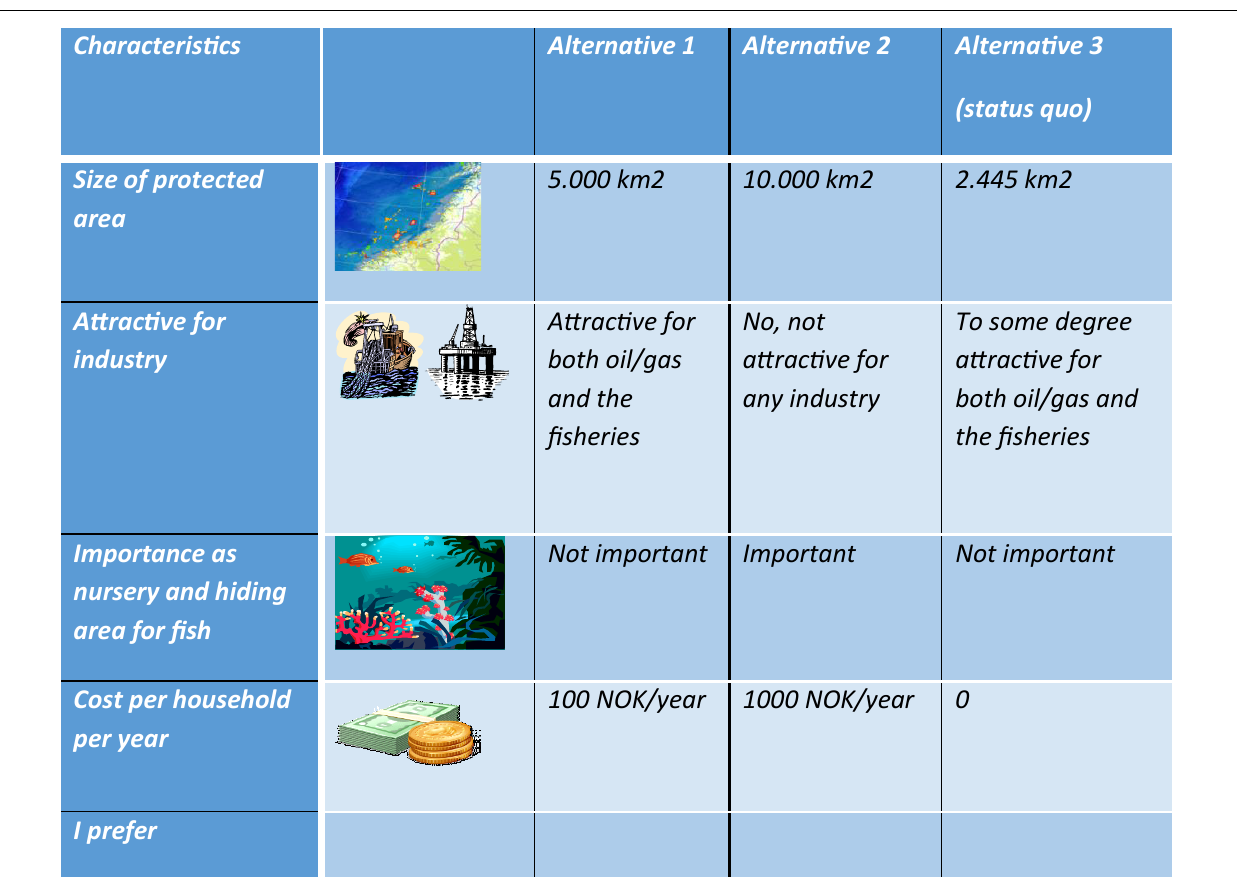
FIGURE A1 | An example of a choice card used in the cold-water coral discrete choice experiment.